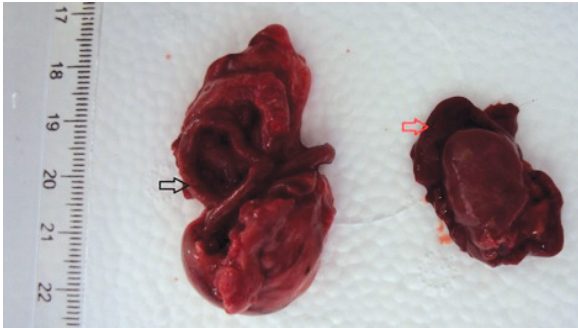
Figure 2. Kidneys from necropsied Galictis cuja . Right kidney increased in size and parasited by Dioctophyme renale (black arrow) and left kidney with normal size and absence of parasitism (red